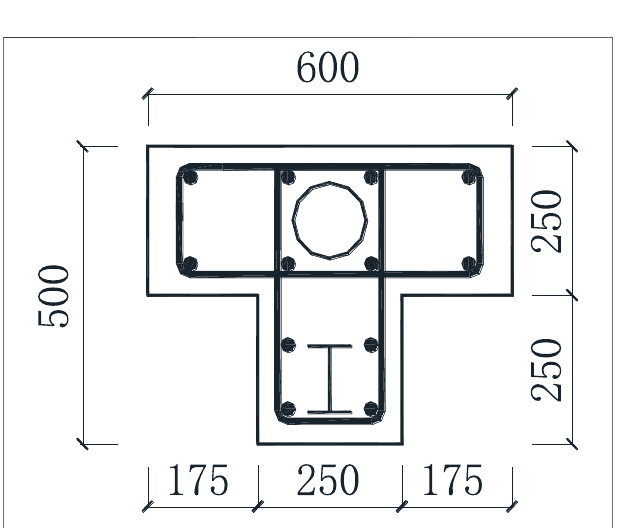
FIGURE 3 | Column cross-sectional dimensions of specimens JD- 1 – JD-3 (Xiang et al., 2017; Xiang et al., 2019).